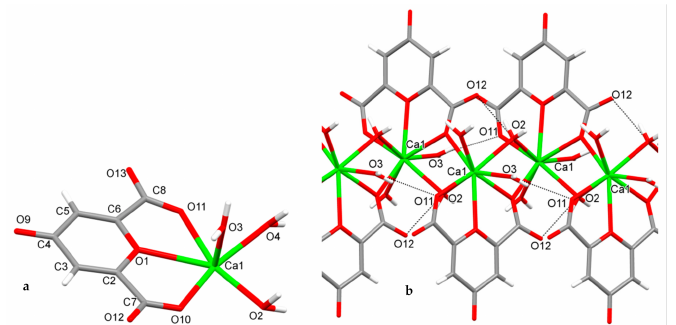
Figure 1. The asymmetric unit ( a ) and the fragment ( b ) of infinite 8-coordinated calcium complex [Ca(ChA)(H 2 O) 3 ] n with intracomplex H-bonds (O3–H . . . O11 and O2–H . . . O12). The reflection intensity was corrected for absorption using the SADABS program